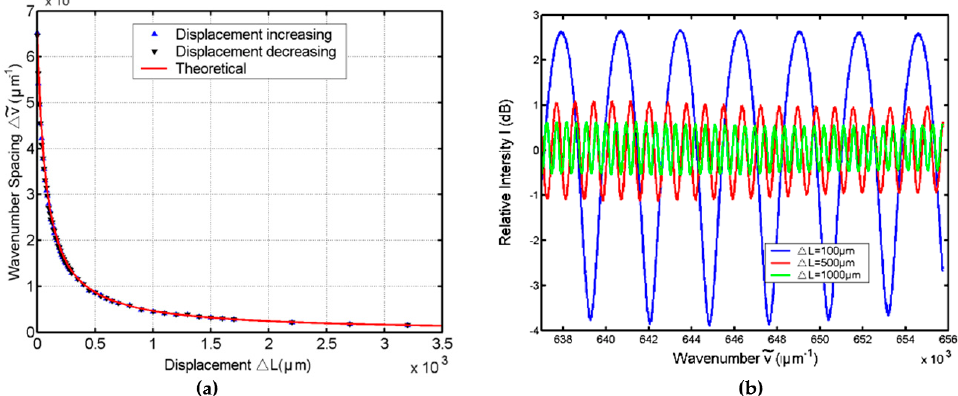
Figure 6. ( a ) Experimental and theoretical plots for the wavenumber spacing versus the displacement of the mirror; ( b ) The interference fringes with various displacements. Copyright (2010) Optics Communications, from Reference [50].